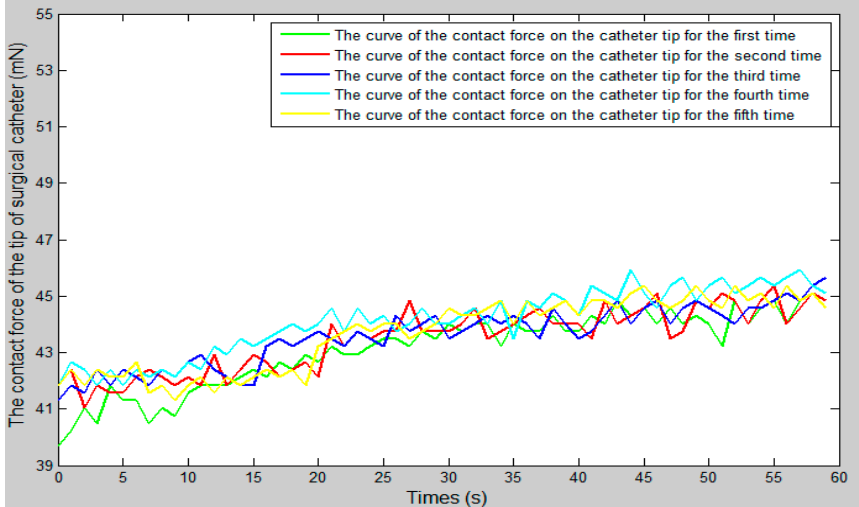
Figure 12. The curve of the contact force of the surgical catheter.